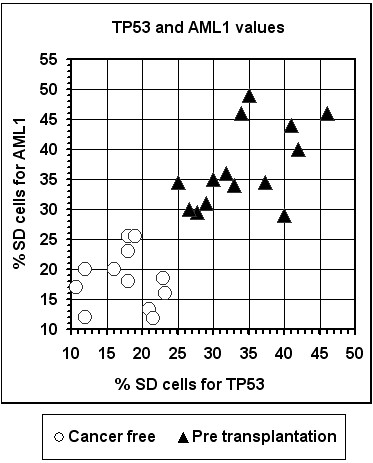
Distribution of bone marrow samples according to their AML1 and TP53 SD values.